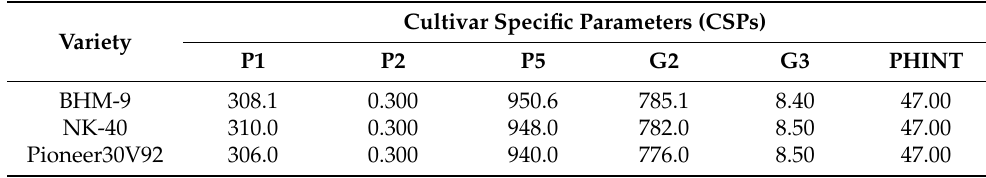
Table 4. CERES-Maize genetic coefficient for BHM-9, NK-40, and Pioneer30V92 varieties.